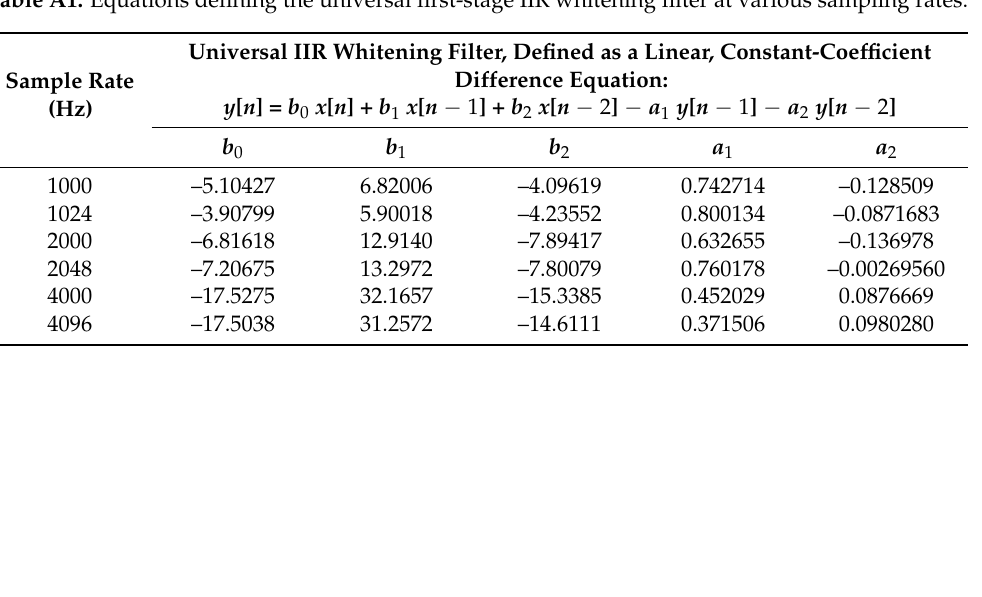
Table A1. Equations defining the universal first-stage IIR whitening filter at various sampling rates.